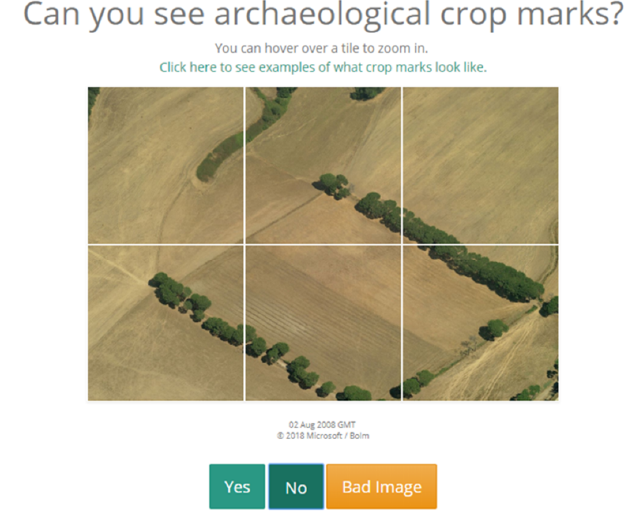
Figure 6. A screenshot of a task presented to a user. Microsoft products are reprinted with permission from Microsoft Corporation.